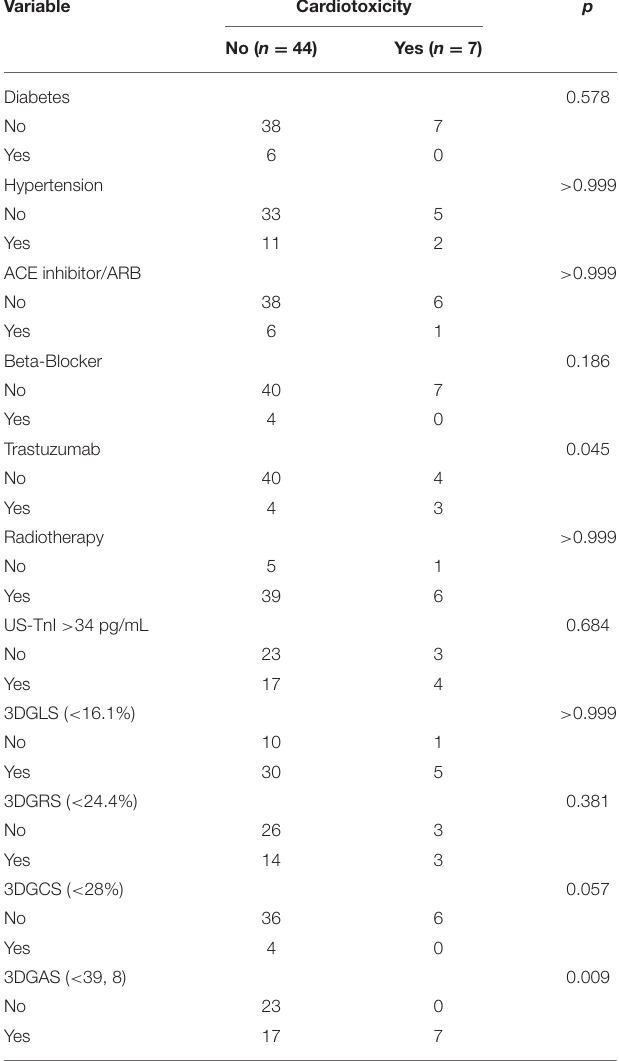
TABLE 6 | Follow-up. Early changes in variables and clinical features during chemotherapy and its association with a subsequent decrease in LVEF (definite